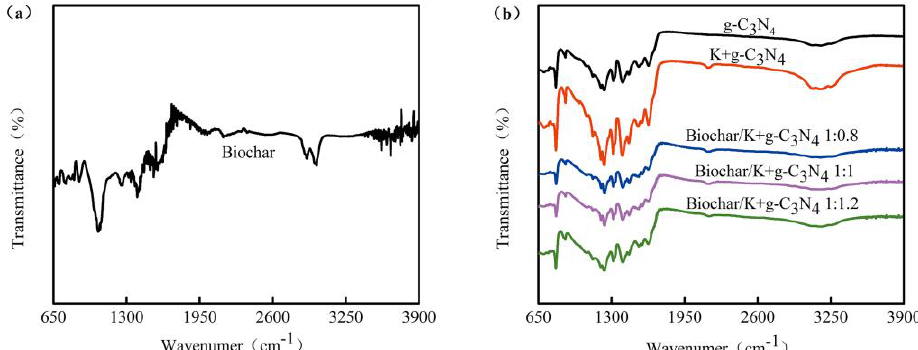
Figure 3. Fourier transform infrared (FTIR) spectra of ( a ) biochar, ( b ) g-C 3 N 4 , K-doped g-C 3 N 4 and biochar-supported K- doped g-C 3 N 4 .